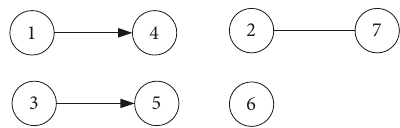
Figure 7: Topological map of block transportation